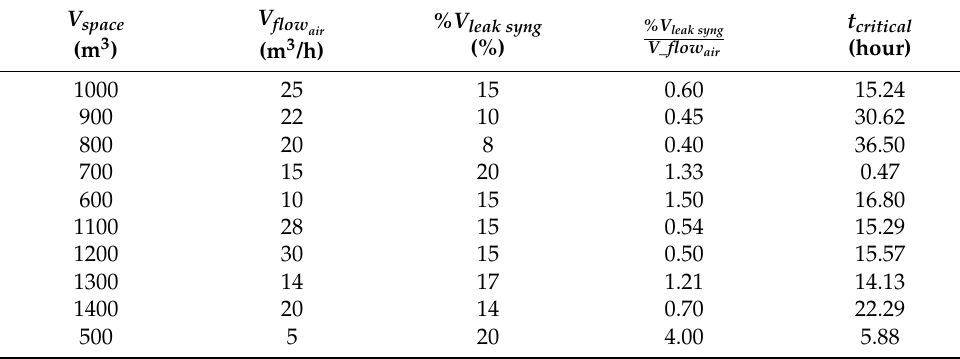
Table 4. Inputs and output of static model no. 3